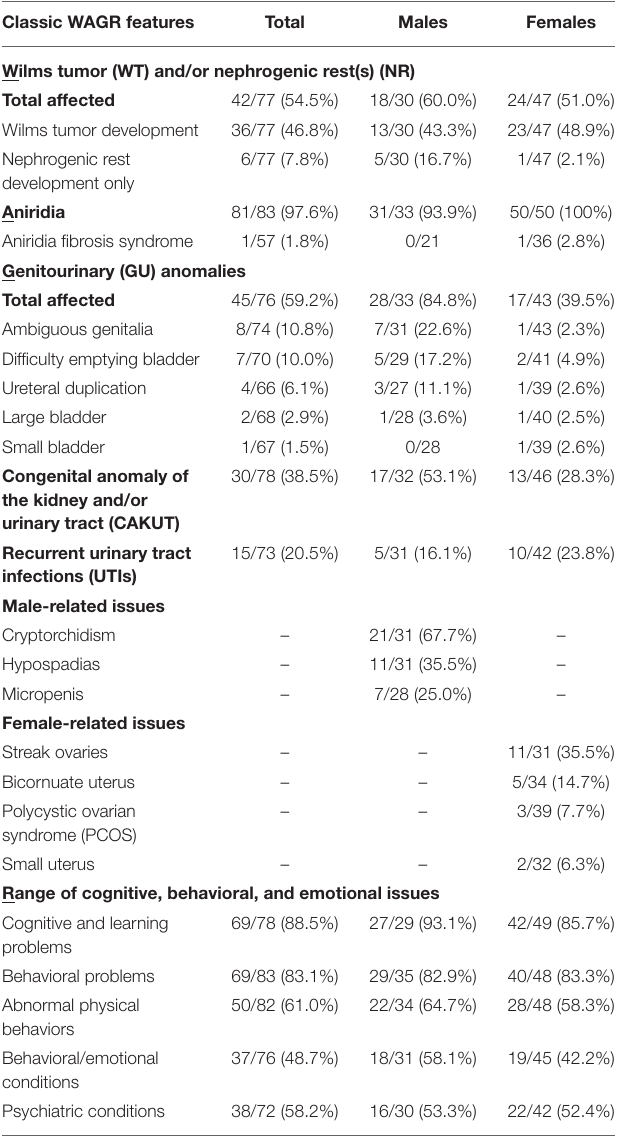
TABLE 1 | Frequency of classic WAGR features in the participants of the WAGR discovery